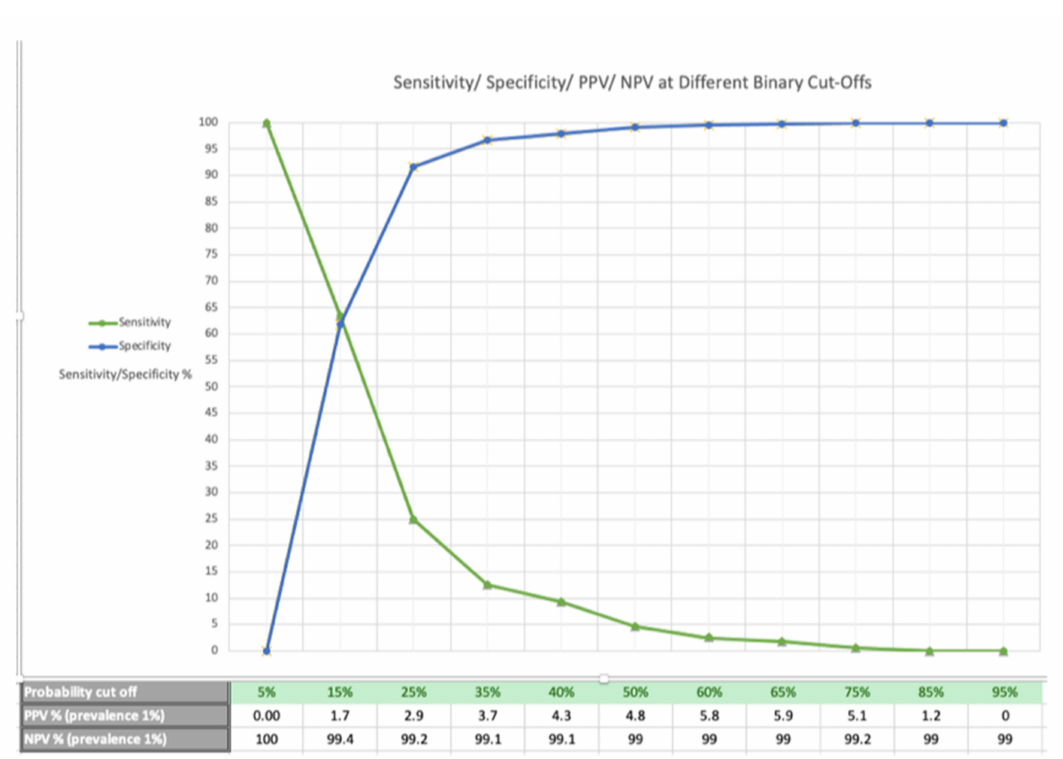
Figure 2. Sensitivity/specificity/positive predictive values (PPV)/negative predictive values (NPV) for a prevalence of 1% at different probability